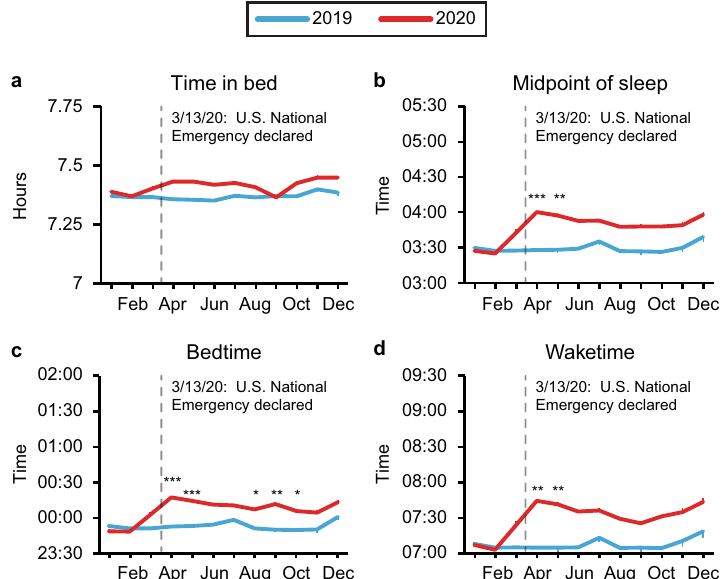
Figure 3. Self-reported sleep duration and timing in the United States during the years 2019 and 2020. Average time in bed ( a ) and midpoint of sleep ( b ) were calculated from self-reported bedtimes ( c ) and waketimes ( d ) for each month in 2019 (blue) and 2020 (red) in the United States. Bonferroni-adjusted p values for comparisons between each month of 2019 to the corresponding month of 2020 are indicated as follows: * p < 0.05, ** p < 0.01, *** p < 0.001. Means ± SEM are